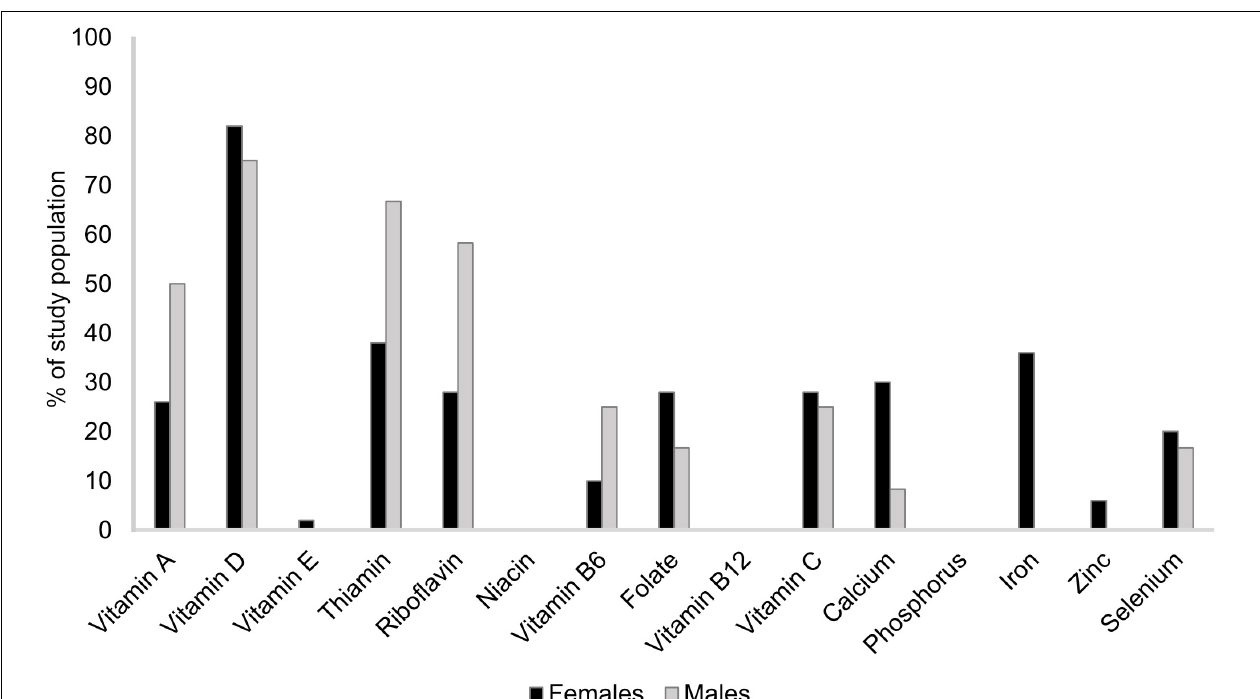
FIGURE 4 | Percentage of study population, 1 stratified by sex, reporting a micronutrient intake below average requirement. 2 1 Patients with rheumatoid arthritis residing in southwestern Sweden (females n = 50, males n = 12). 2 Nordic Council Of Ministers (31). Nordic Nutrition Recommendations 2012: Integrating nutrition and physical activity [Internet]. Copenhagen: Nordisk Ministerråd; [cited 2021 1 November]. Available from http://urn.kb.se/resolve?urn=urn:nbn:se:norden:org: